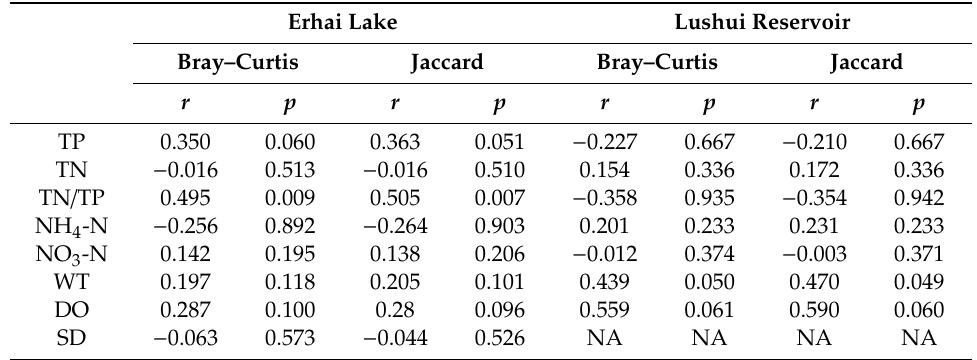
Table 2. Mantel tests for the correlations between environmental factors and cyanobacterial community compositions. Erhai Lake Lushui Reservoir Bray–Curtis Jaccard Bray–Curtis